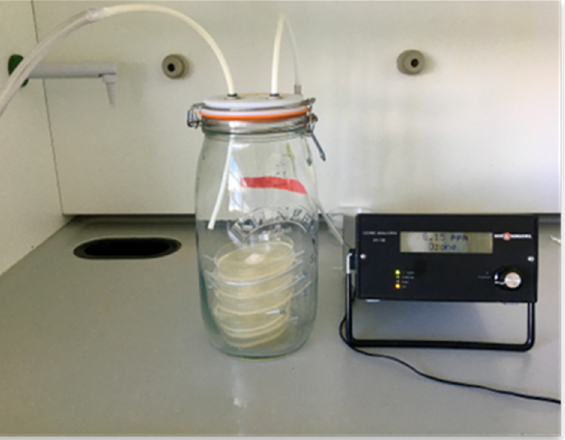
Figure 2. Ozone meter and a hermetic pot in which Petri dishes were put during ozone treatments in in vitro trials.